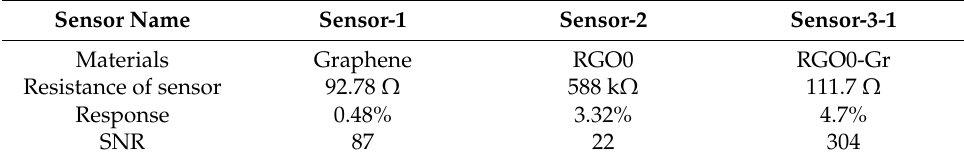
Table 2. Sensing materials and electrical parameters comparison of three